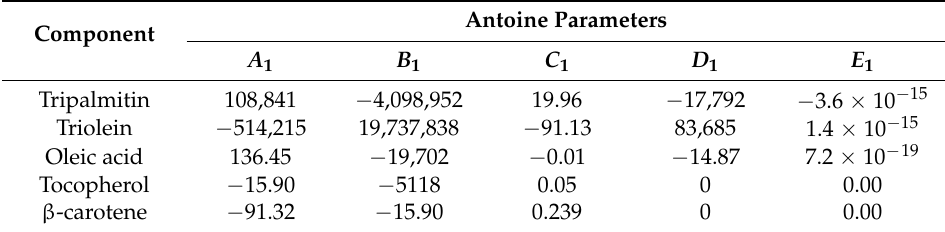
Table 3. Pure component parameters for Equation (2), reproduced with permission from [13]. Copyright Springer, 2003.